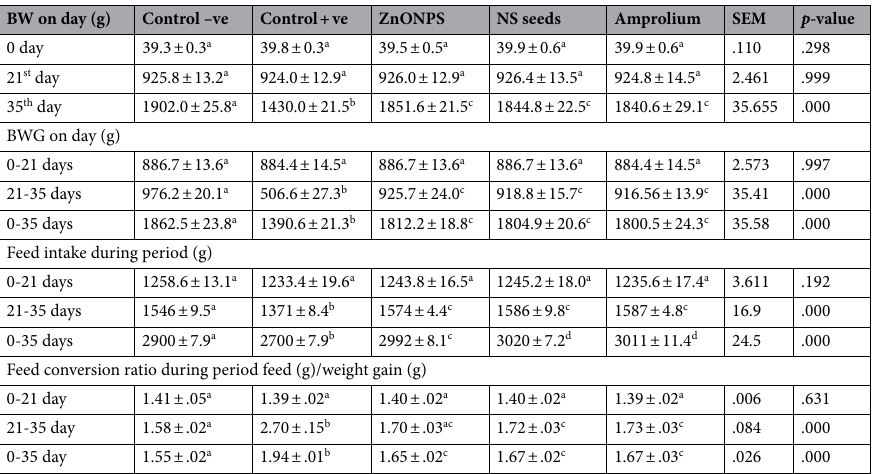
Table 1. Growth performance of the broiler birds challenged with Eimeria tenella and given different treatments. (Mean ± S.D.) Values are Mean ± S.D, Control –ve = Un-infected and un-treated, Control + ve = Infected and un-treated, ZnONPs = Infected and treated with 60 mg/kg ZnONPs orally, NS seeds = Infected and treated with 1% Nigella sativa crushed seeds, Amprolium = Infected and treated with amprolium. BW: body weight; BWG: body weight gain; FI: feed intake; FCR: feed conversion ratio (FI/BWG); SEM: standard error of mean. a,b, c,d mean within a row with different superscripts are significantly different at (p < 0.05).